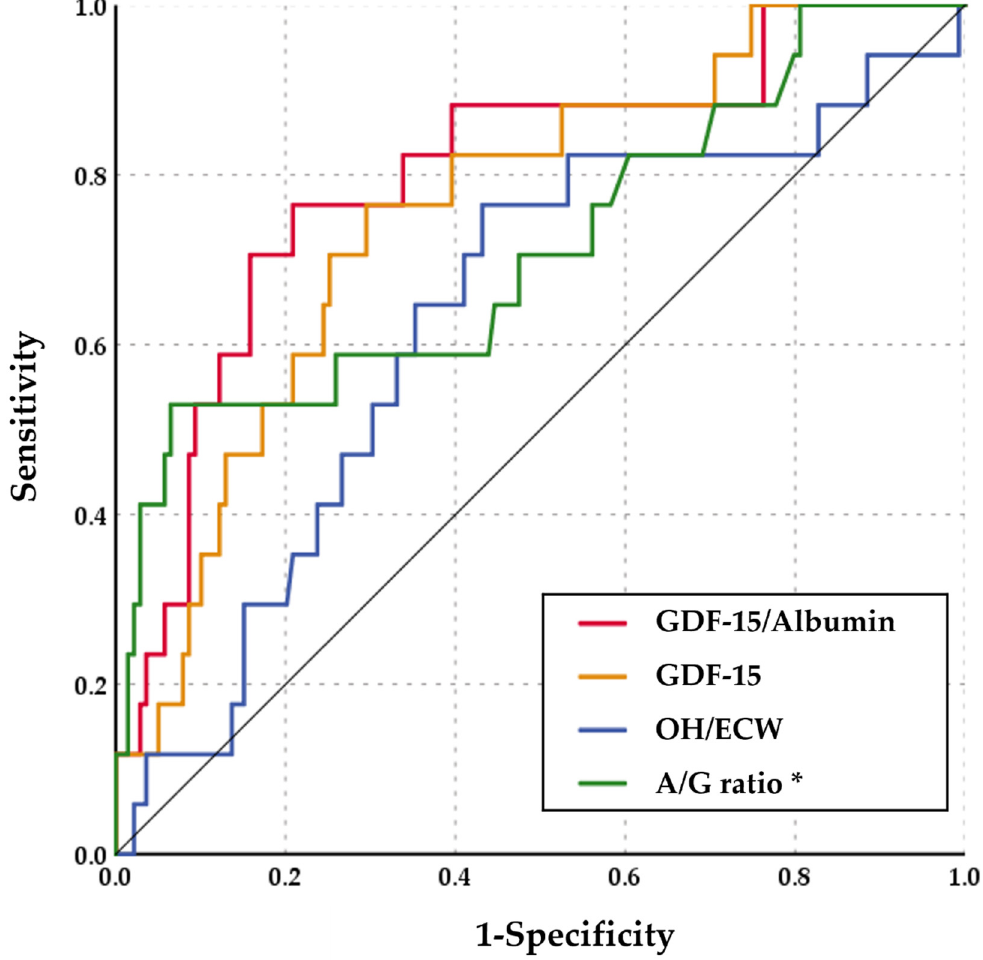
Figure 3. ROC analysis comparing sensitivity and specificity of GDF-15/albumin, GDF-15, OH/ECW, and A/G ratio for predicting all-cause mortality. * The test direction of ROC curve analysis of A/G ratio was opposite from that of GDF-15/Albumin, GDF-15 and